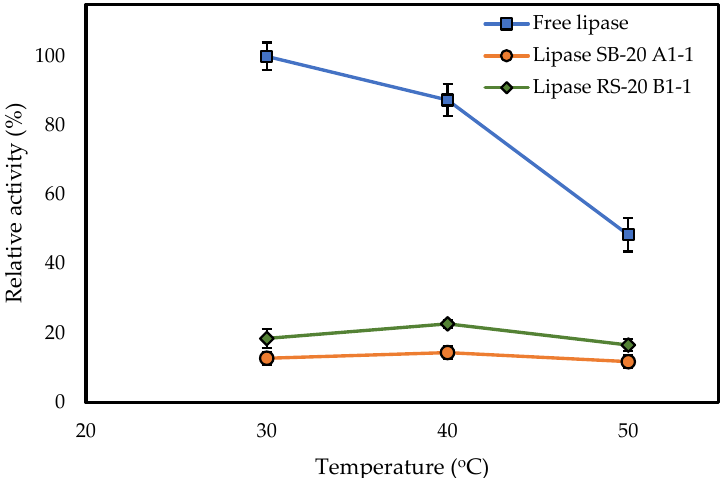
Figure 8. Effect of hydrolysis temperature on the enzyme activities of lipase SB-20 A1-1 and lipase RS-20 B1-1 relative to free lipase activity. Hydrolysis was carried out for 2 h.